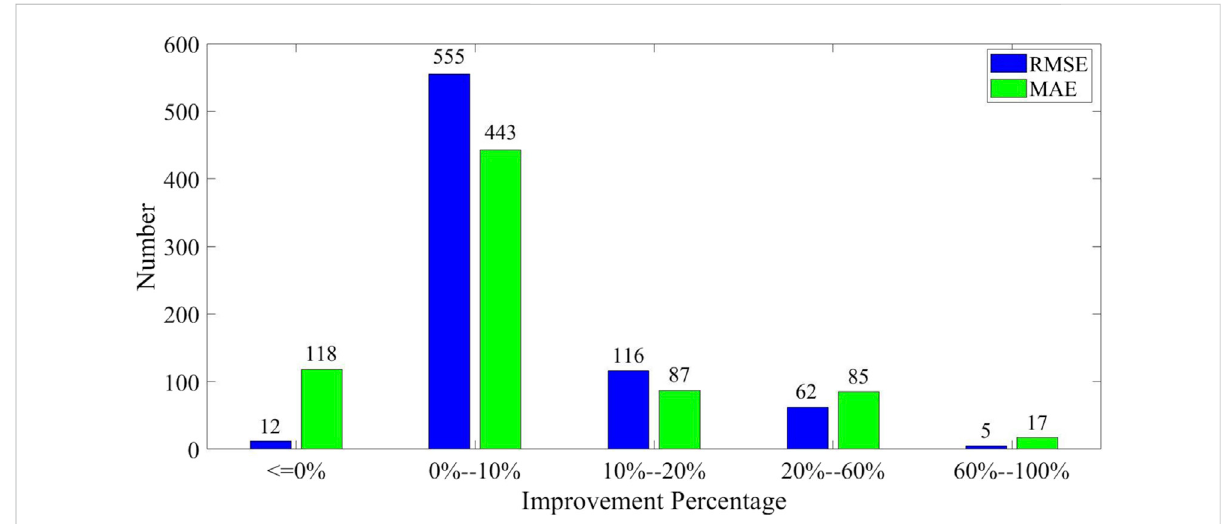
FIGURE 3 Statistics of improvement percentage of the proposed method compared to the benchmark method.